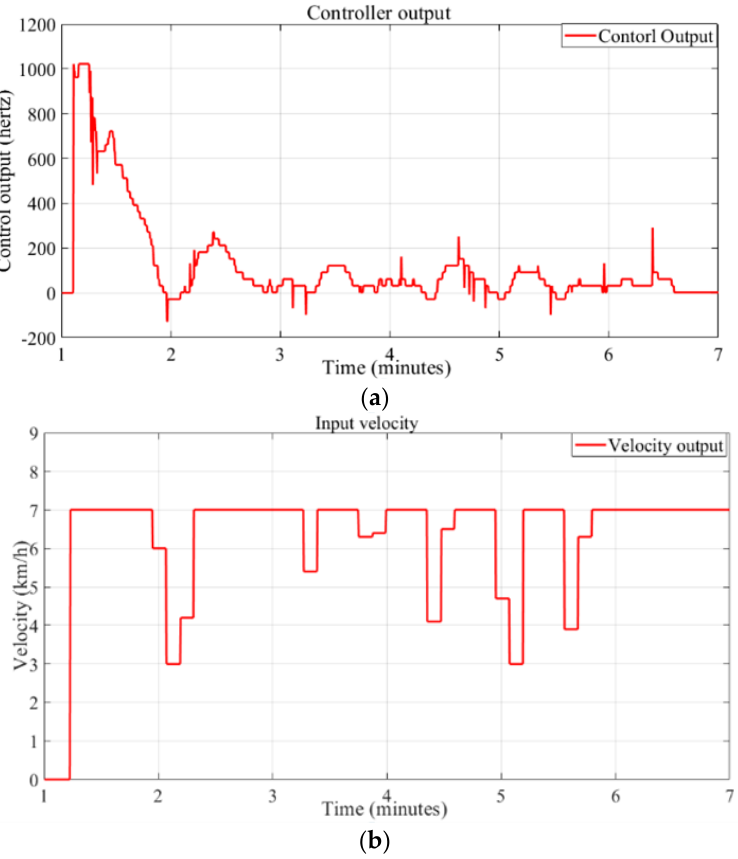
Figure 12. Hertz and velocity relationship: ( a ) hertz, ( b ) velocity.